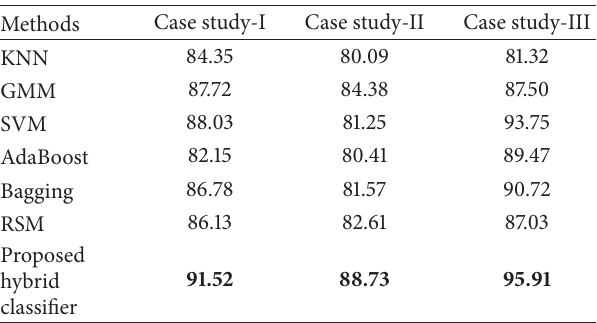
Figure 10: ROC curves of proposed framework for key player detection. Table 8: Comparison of hybrid classifier with existing ensemble methods.